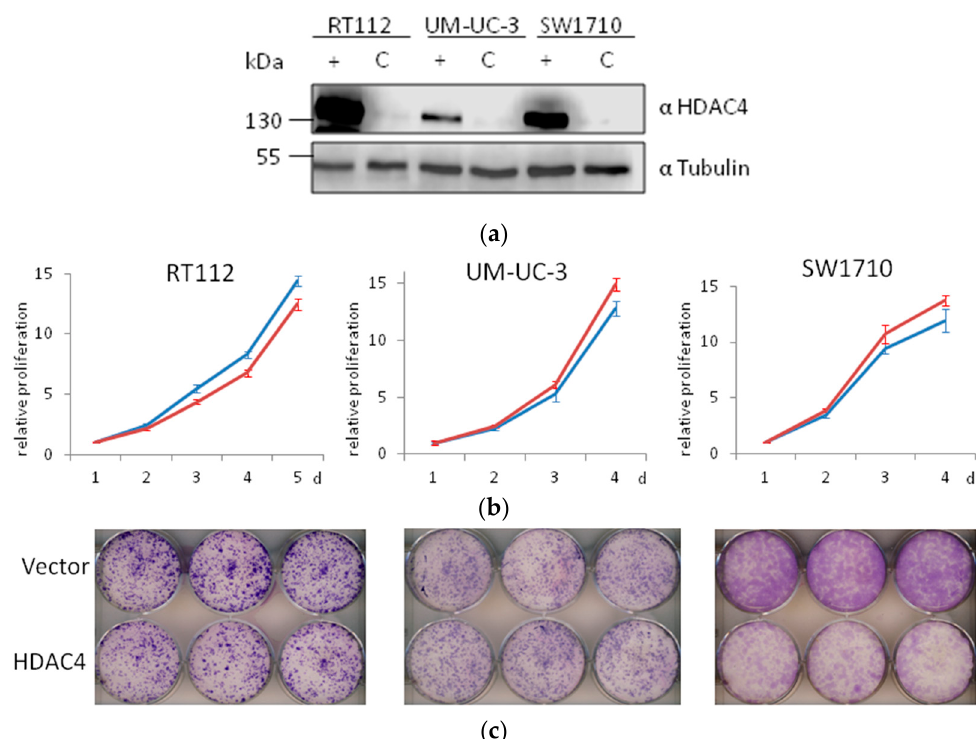
Figure 11. Effects of HDAC4 overexpression on UC cell lines. ( a ) Immunoblot validation of HDAC4 overexpression in three UC cell lines. α -Tubulin was used as a loading control. C: vector-only, + HDAC4-transduced cells. ( b ) MTT assay of proliferation of vector-only (red) or HDAC4-transduced (blue) cell lines. For each cell line, control values at day 1 are set as 1. ( c ) Representative photographs of clone formation assays of vector-only (top) or HDAC4-transduced (bottom) cell lines.